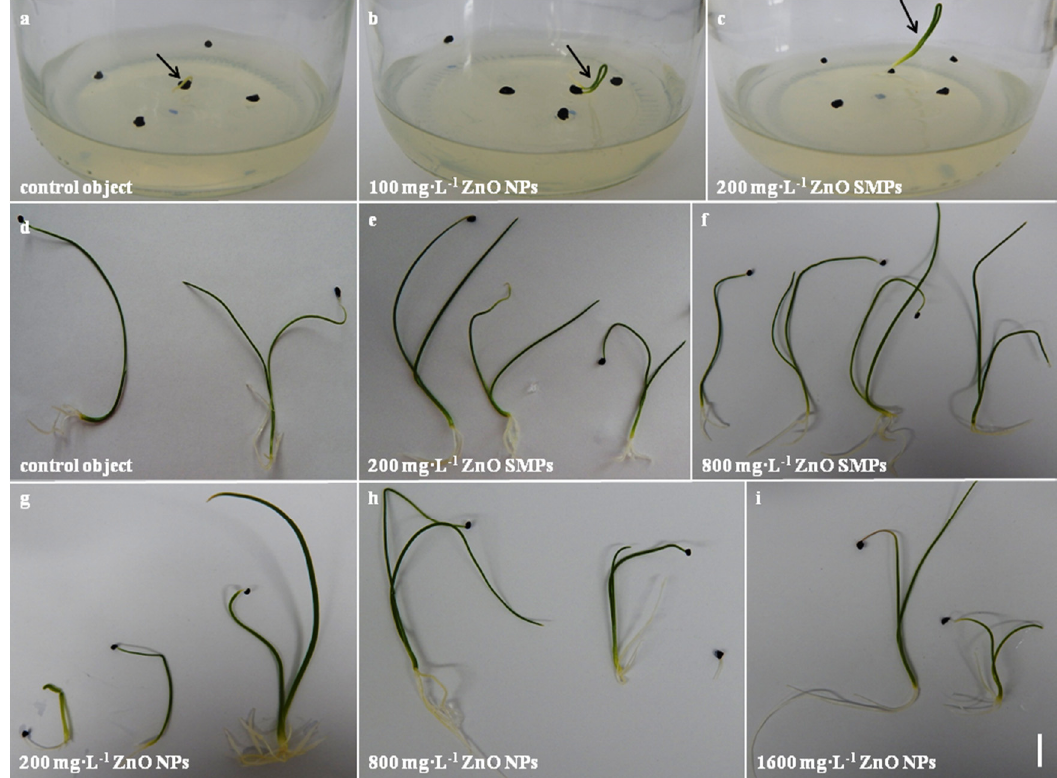
Figure 6. In vitro culture of Allium cepa L. ‘Sochaczewska’ on the modified MS medium (indicated with an arrow). First germinating seed ( a ); cotyledon developing ( b , c ); three-week-old plantlets obtained after application of ZnO SMPs or ZnO NPs at different concentrations ( d–i ). Bar = 1 cm.